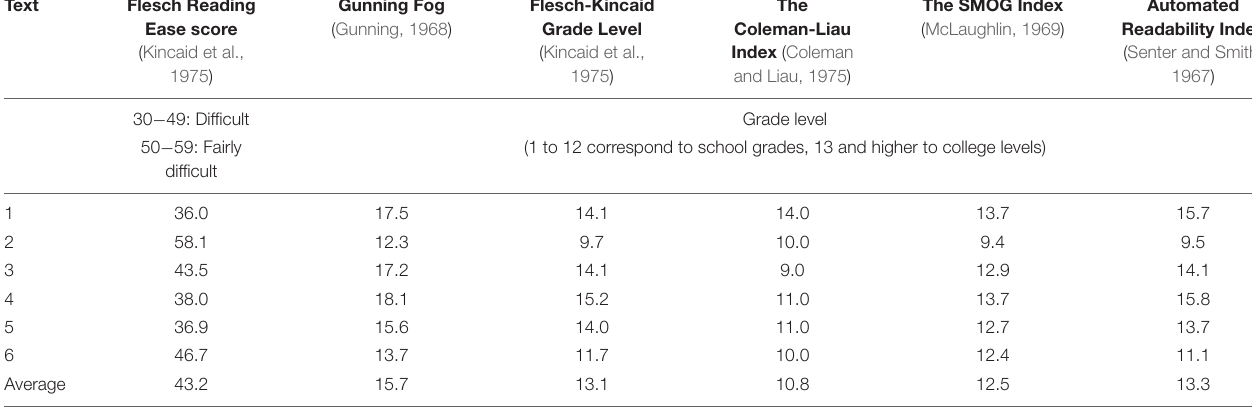
TABLE 9 | Readability indices for the texts used in the experimental evaluation of referential choice. Text